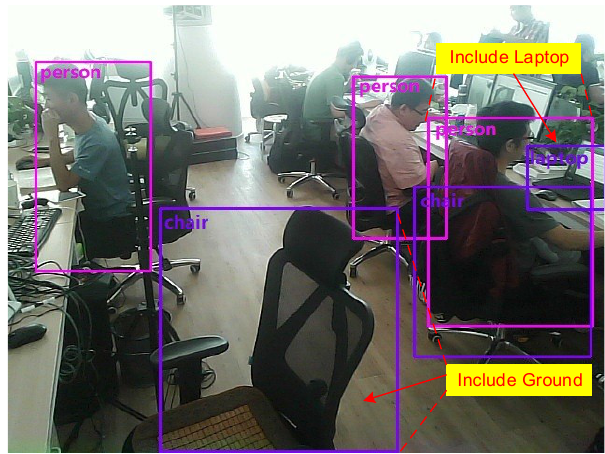
Figure 7. Example of CNN-based object